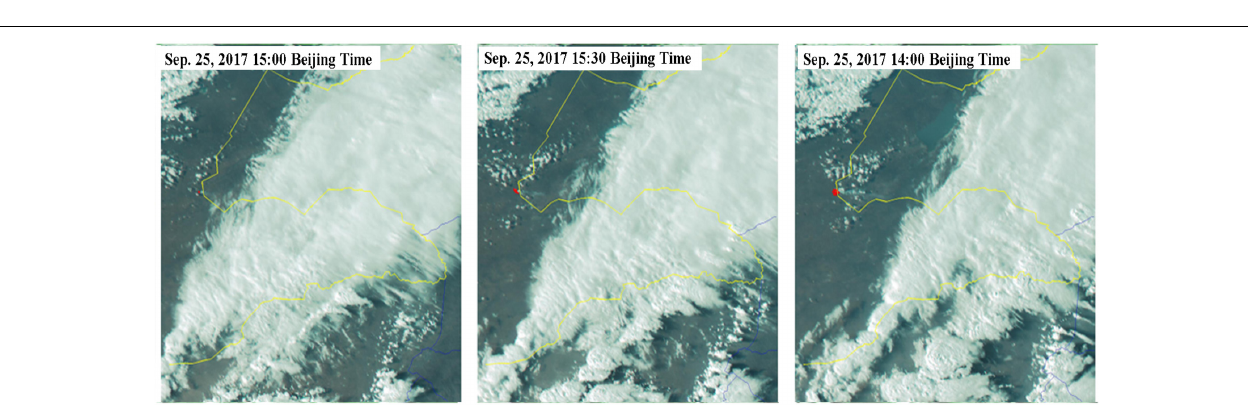
FIGURE 8 | Himawari/AHI fire monitoring over Inner Mongolia, China, on 25 September 2017, 15:00–16:00 Beijing Time (2 km resolution).